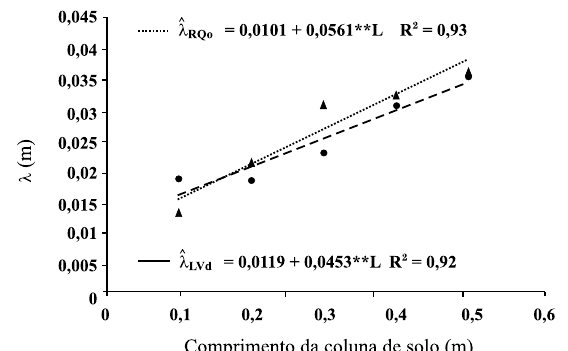
Figura 5. Dispersividades ( λλλλλ ) do potássio estimadas (linhas) e médias dos valores experimentais observados num Neossolo Quartzarênico órtico ( ) e num Latossolo Vermelho distrófico ( ), em função do comprimento da coluna de solo